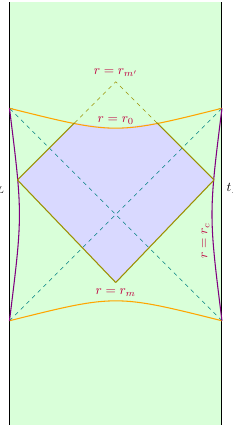
Figure 2 . Penrose diagram of AdS 2 geometry. The green part is covered by AdS global coordinates, while the Rindler coordinates cover a portion shown in the (cid:12)gure. The actual WDW patch is shown by blue